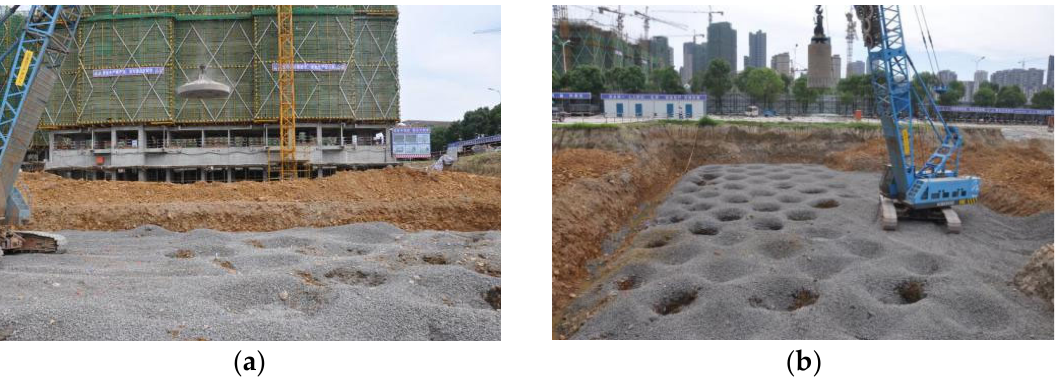
Figure 3. Layout of foundation and settlement monitoring points of 9# building.